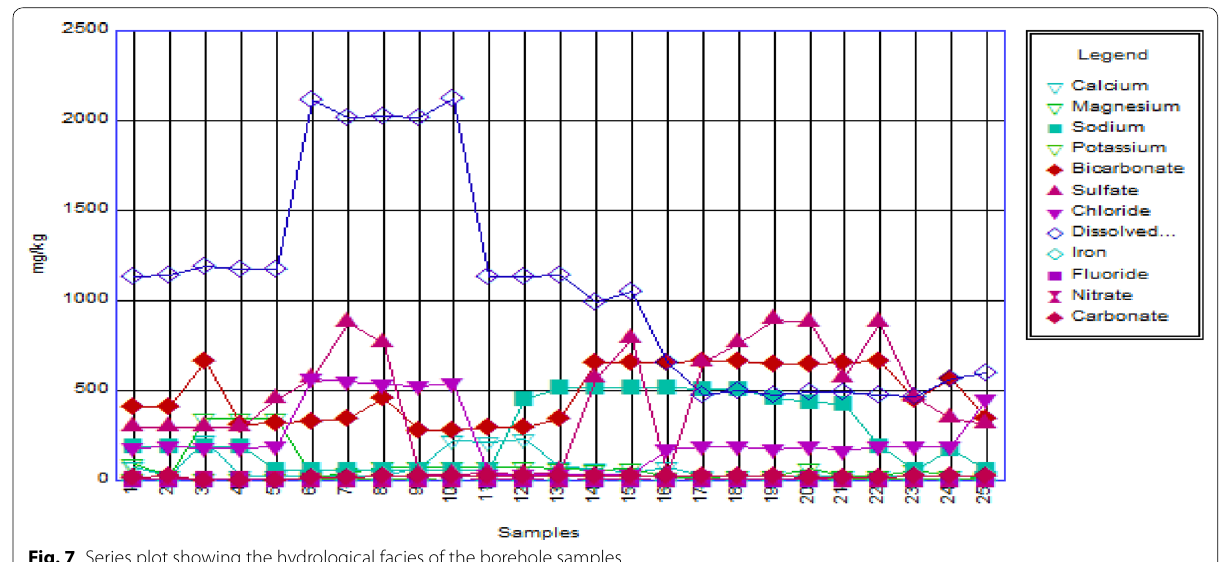
Fig. 7 Series plot showing the hydrological facies of the borehole samples